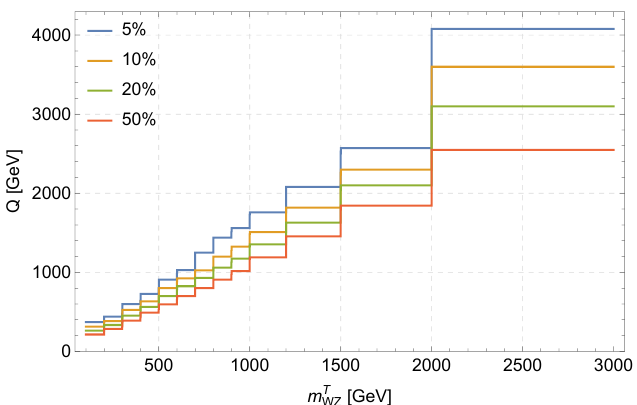
Figure 5 . We show, for the process q (cid:22) q ! WZ with (cid:21) Z turned on, the leakage as a function of m T , see main text for the WZ